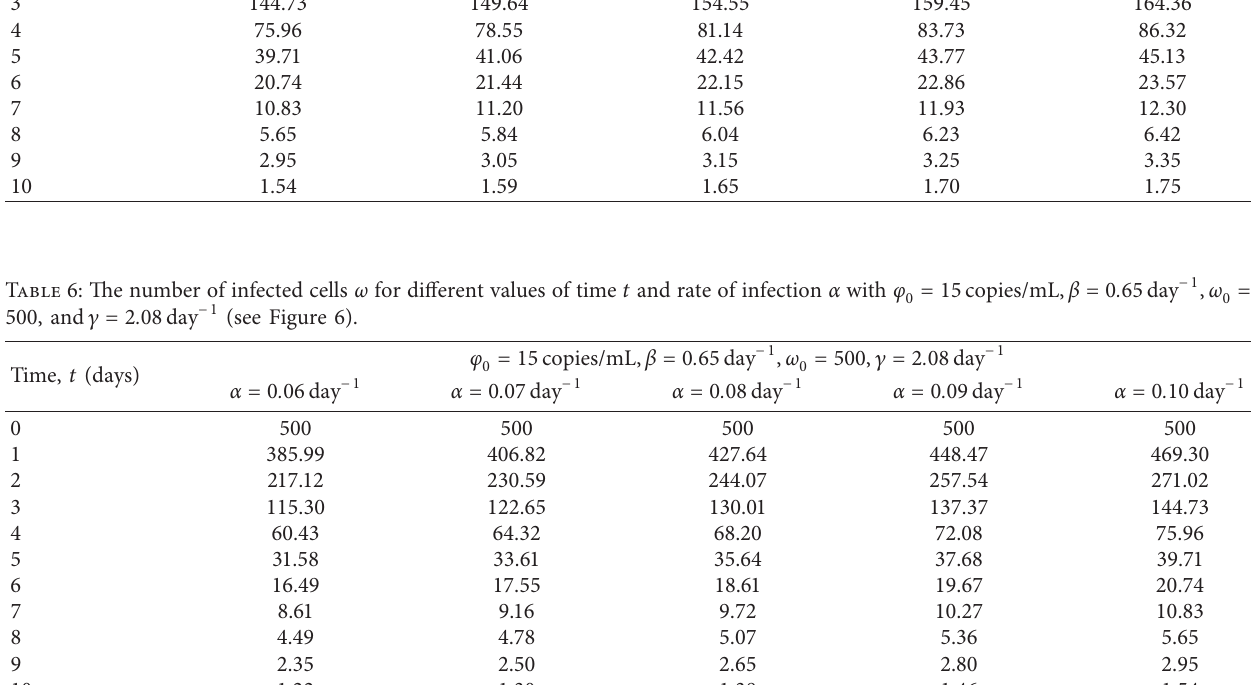
Table 5: The number of infected cells ω for different values of time t and initial concentration of viral particles in plasma φ